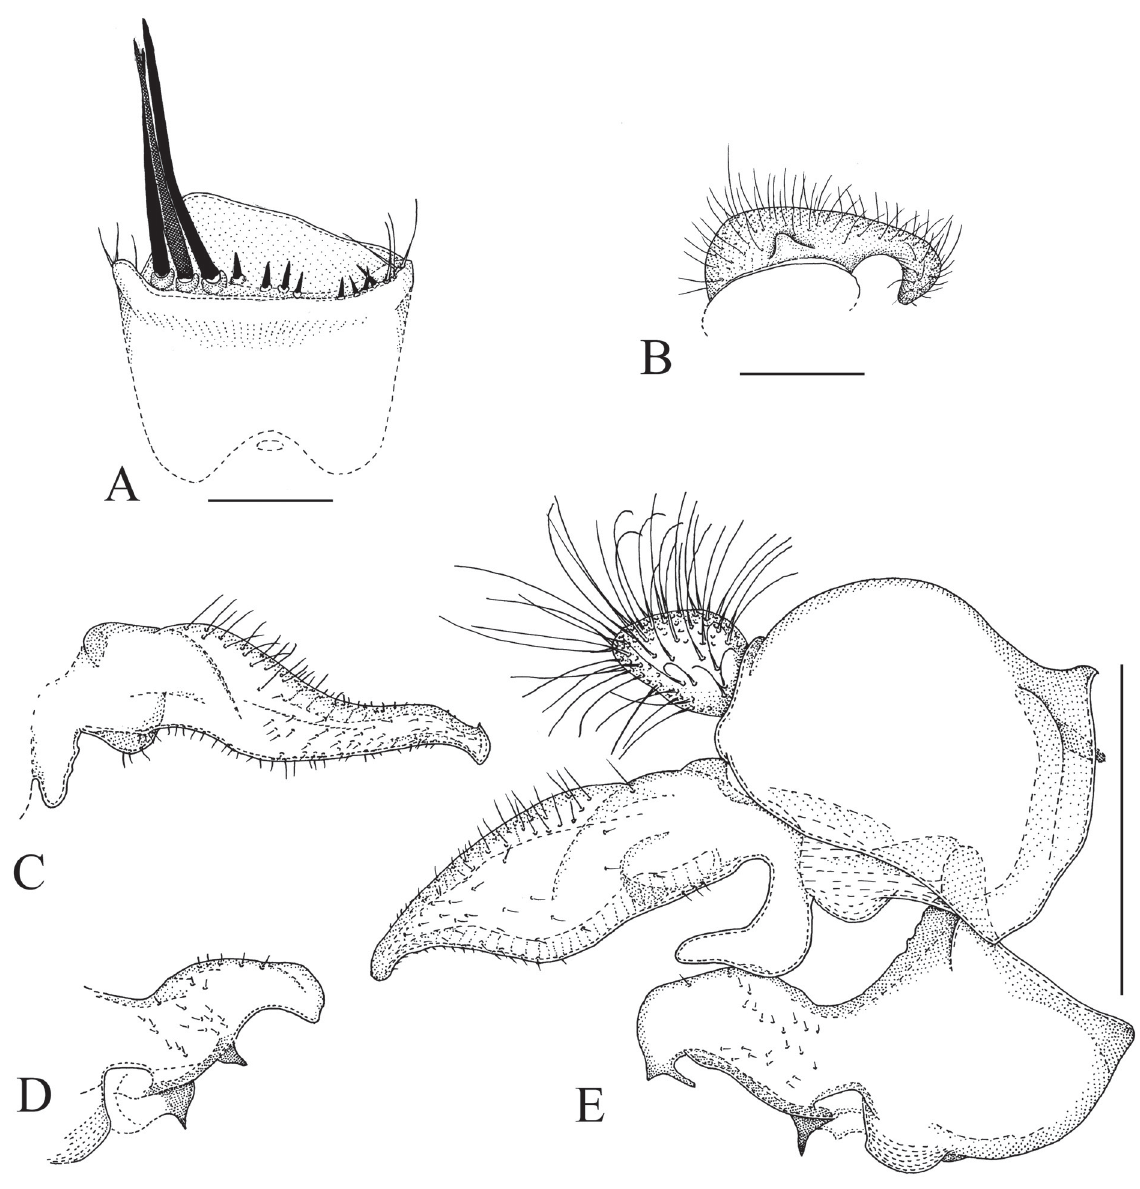
Fig. 27. Sphegina (Asiosphegina) distincta sp. nov., holotype, ♂ . A . Sternum IV, ventral vie w. B . Sternum VII, ventral view. C . Left surstylus, lateral view. D . Left superior lobe with associated parts, lateral view. E . Genitalia, right side, lateral view. Scale bars = 0.5